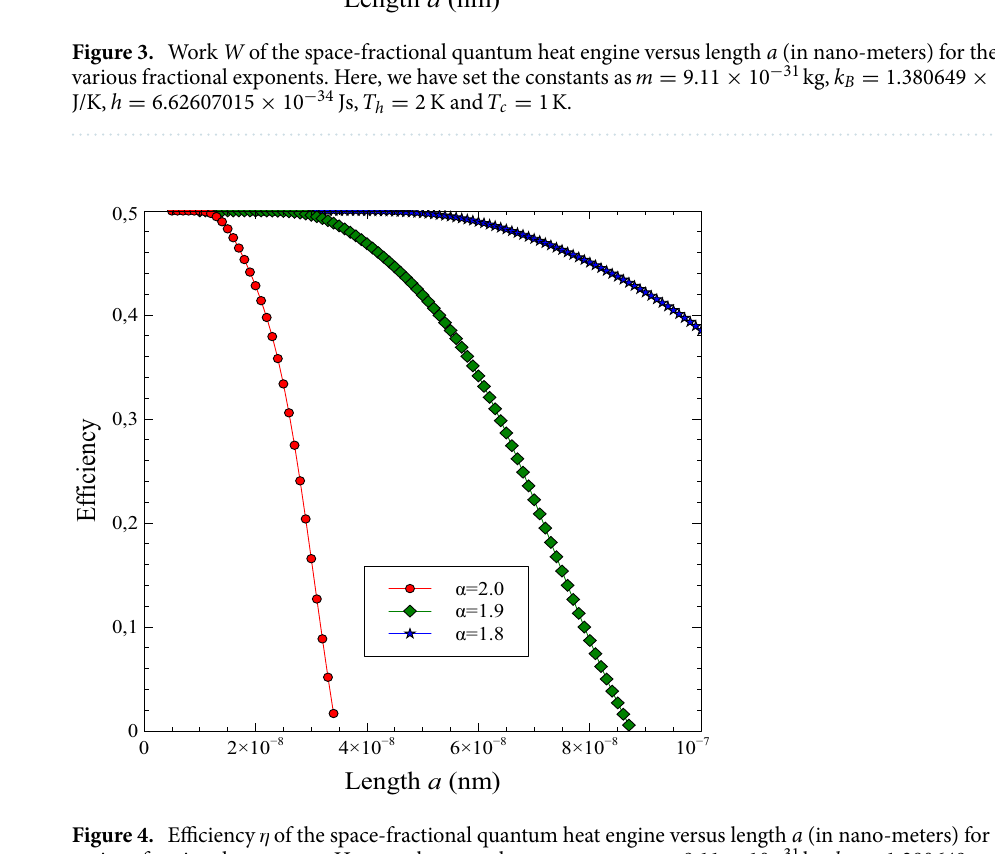
31 9.11 10 1.380649 10 kg, k B − − = × = ×